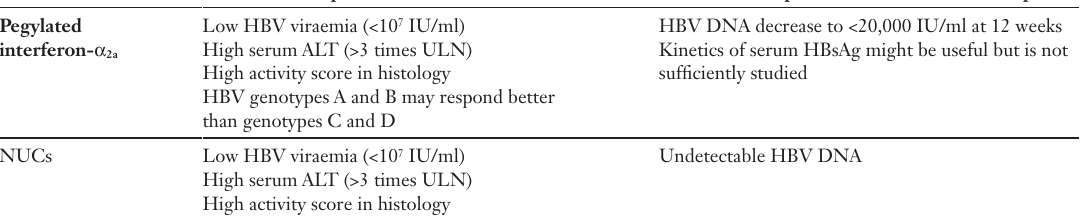
Pre-treatment predictors for HBe seroconversion